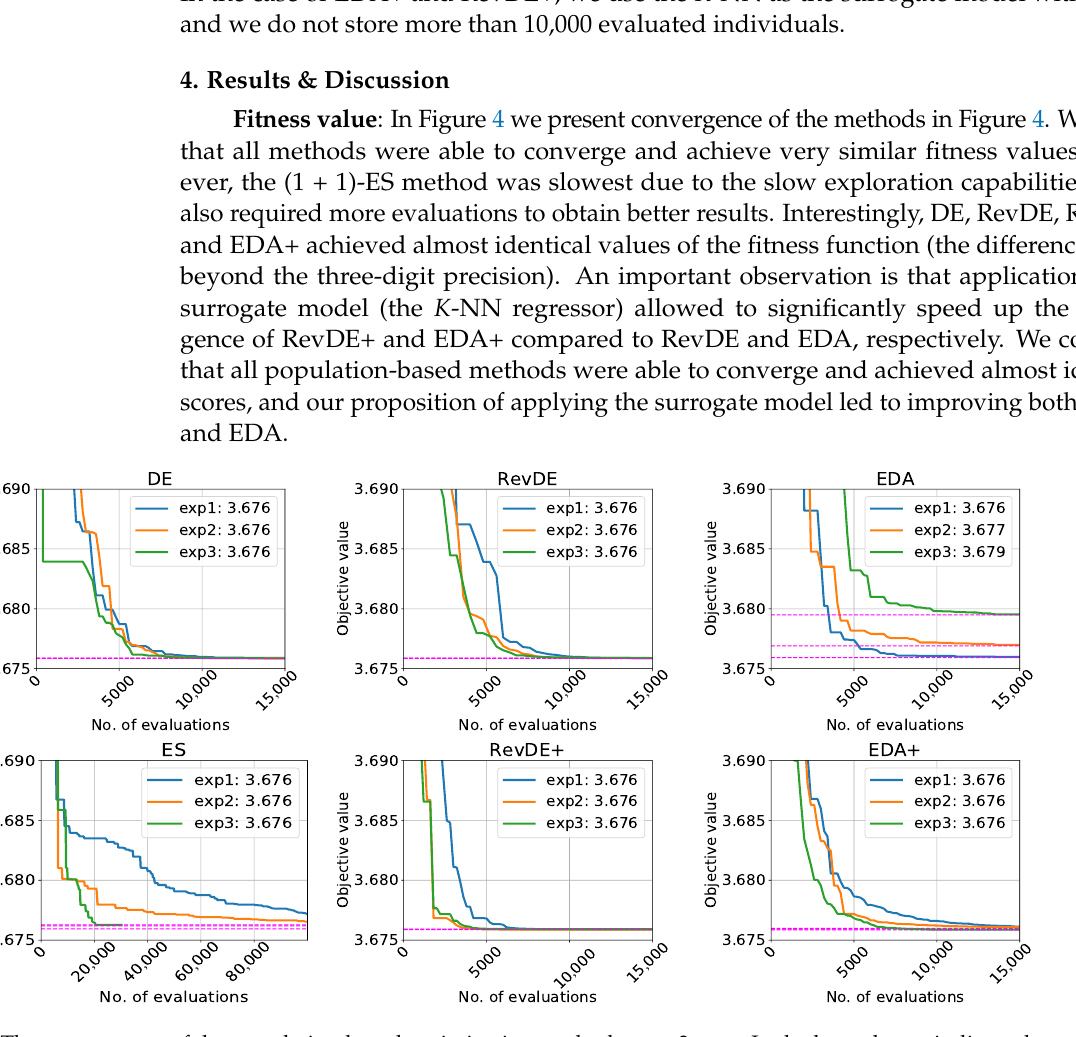
Figure 4. The convergence of the population-based optimization methods over 3 runs. In the legends, we indicate the value of the fitness function after the methods